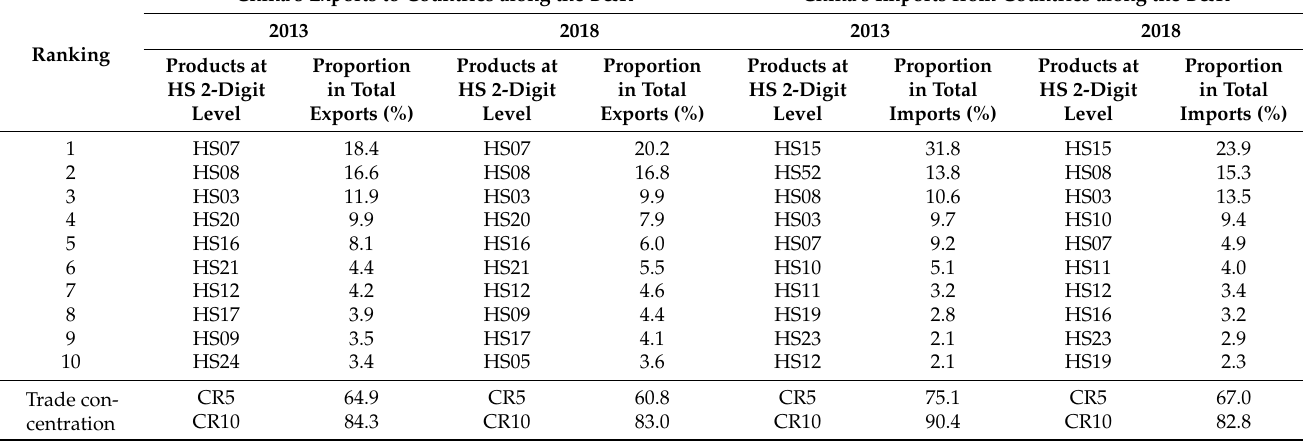
Table 2. The top 10 categories of agricultural products at Harmonized System (HS) 2-digit level in their proportion in total agricultural trade between countries along the B&R and China in 2013 and